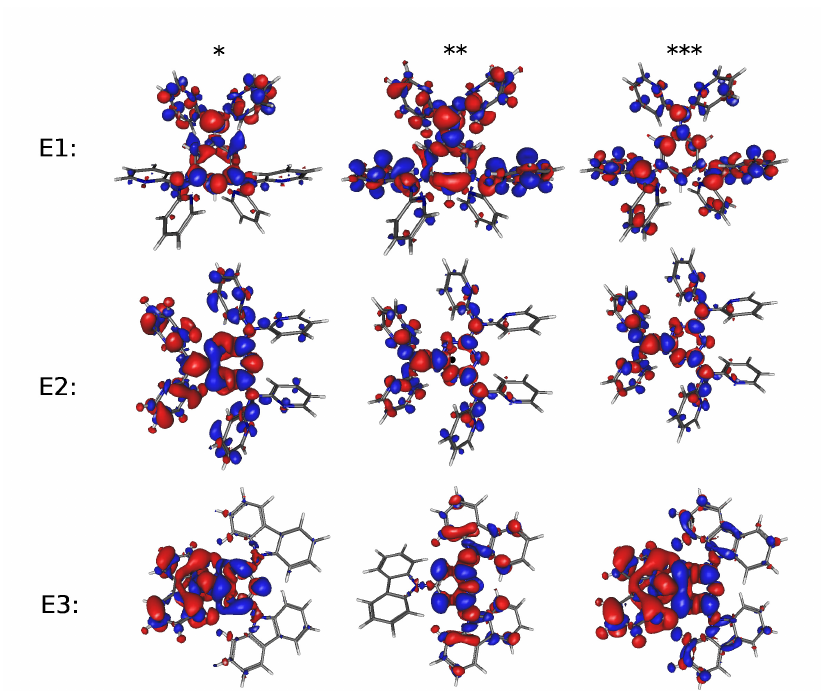
Figure 5. Iso-contour plots (cutoff value of 0.001 au.) of ground- and excited-state density difference for the electron-acceptor systems here studied (E1, E2 and E3). *, ** and *** refer to the first, second and third excited-states,